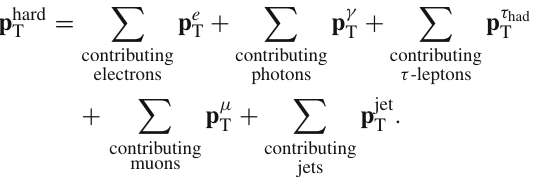
scaled up and down to give an uncertainty